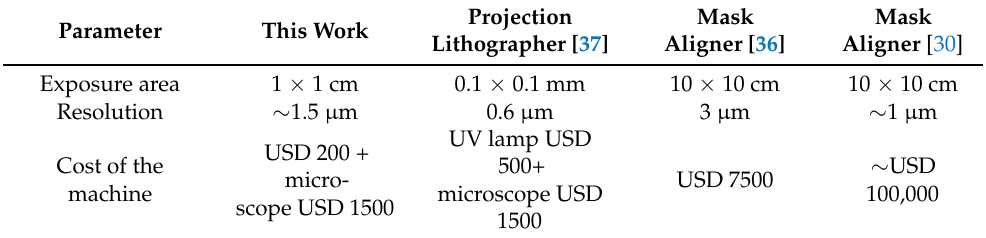
Table 2. Comparison of table-top and home-made mask lithographers. Parameter This